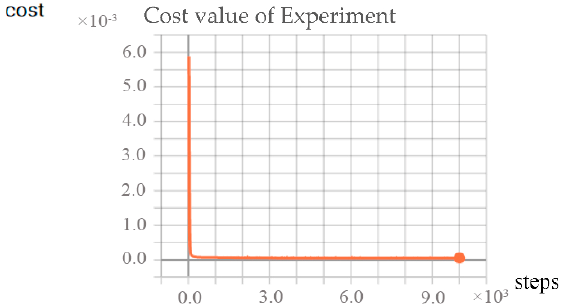
Figure 12. The loss function curves of the model based on the experiment with No. 2 training datasets and δ = 0.0001, with 10,000 steps.